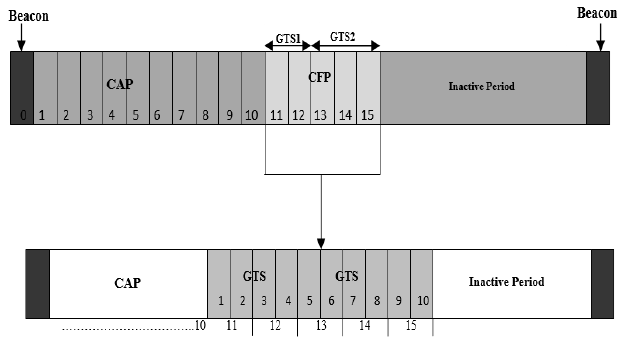
Fig. 3 . Enhanced IEEE 802.15.4 superframe